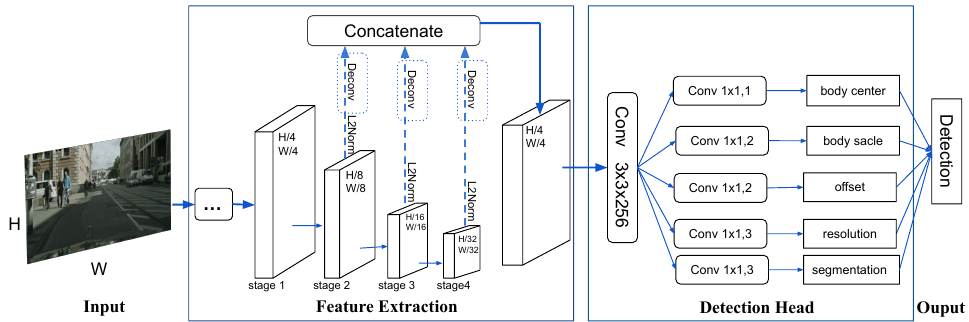
Figure 1. The architecture of CSPRS includes two parts: feature extraction and the detection head. The backbone of the detector is ResNeSt101 [17]. In the detection head, there are four output prediction branches, which are 1 × 1 convolution